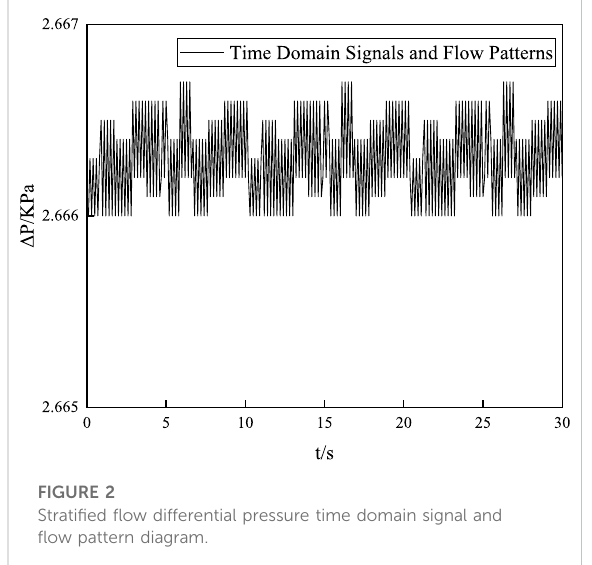
FIGURE 2 Strati fi ed fl ow differential pressure time domain signal and fl ow pattern diagram.